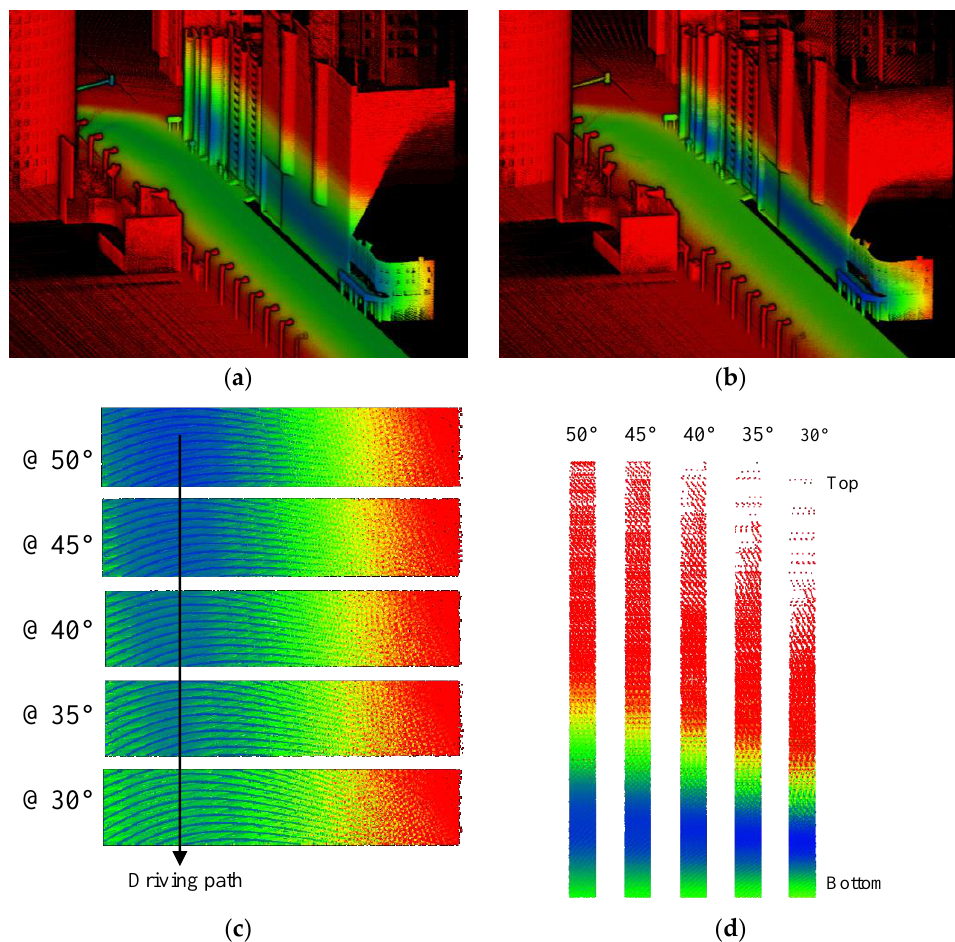
Figure 17. Accuracy labeled point clouds scanned by Pandar64 (red 𝜎 ≥ 5 cm) ( a ) Accuracy at 50° Lidar tilt angle. ( b ) Accuracy at 30° Lidar tilt angle. ( c ) Accuracy estimated at the ground slice for every tilting angle. ( d ) Accuracy estimated at the façade slice for every tilting angle. Table 2. The estimated average standard deviation on the ground and facade slices using